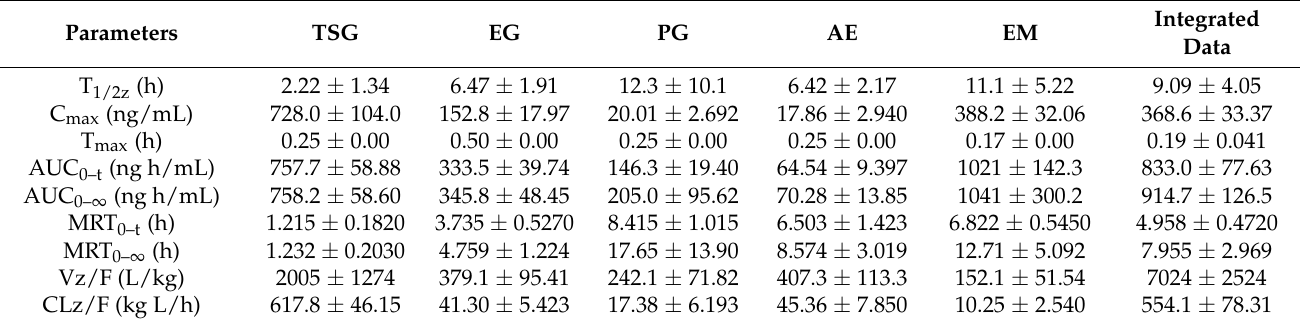
Figure 4. Mean plasma concentration–time curves for ( A ) TSG, ( B ) EG, ( C ) PG, ( D ) AE, and ( E ) EM and ( F ) integrated mean plasma concentration–time curve in rats after oral administration of PM ( n = 6). Table 5. Pharmacokinetic and integral pharmacokinetics parameters of PM using an AUC-based weighting approach ( n = 6).